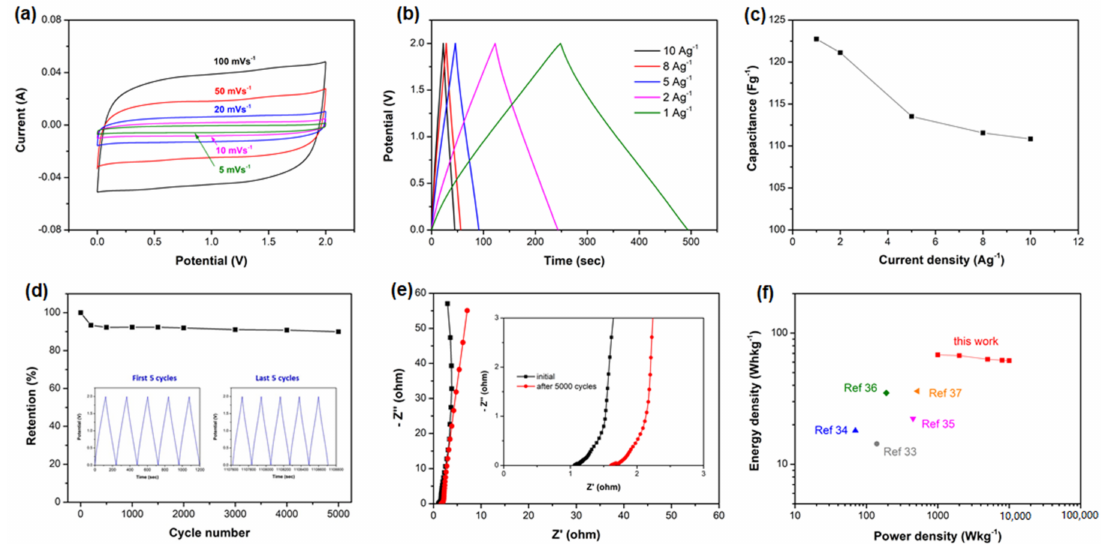
Figure 6. Electrochemical characteristics of the solid-state SRAC5 / Ni // SRAC5 / Ni supercapacitor: ( a ) CV curves at various scan rates within a voltage window of 2 V; ( b ) GCD curves at various current densities; ( c ) the gravimetric capacitance as a function of current density; ( d ) cycling performance at a current density of 2 A g − 1 (inset: the charge–discharge curves of the first and last 5 cycles); ( e ) Nyquist plots of the initial and after 5000 cycles; and ( f ) Ragone plots comparison of the SRAC5 / Ni // SRAC5 / Ni SSC versus previously reported soybean-based SSC devices. Table 3. Comparison of energy storage performance of soybean-based activated carbons. Preparation